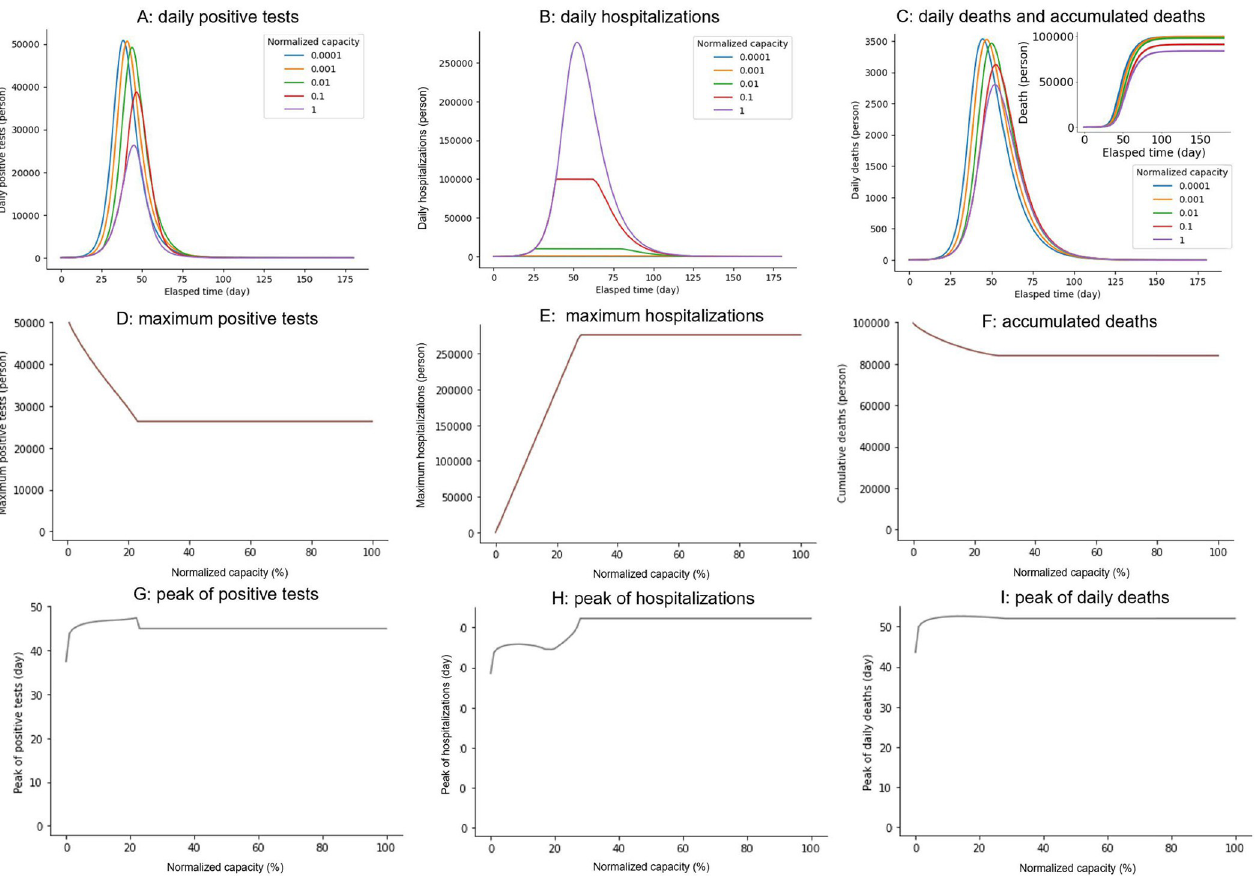
Fig 3. Impact of hospitalization capacity on the three variables. Time courses of (A) Daily reports of positive test results. (B) Daily reports of hospitalizations. (C) Daily reports of deaths with varying hospitalization capacity. C/N indicates the capacity normalized to the total population. Hospitalization capacity dependencies of (D) Maximum positive reports. (E) Maximum hospitalizations. (F) Cumulative deaths. Hospitalization capacity-dependencies of (G) Peak of daily reports of positive tests. (H) Peak of hospitalizations. (I) Peak of daily